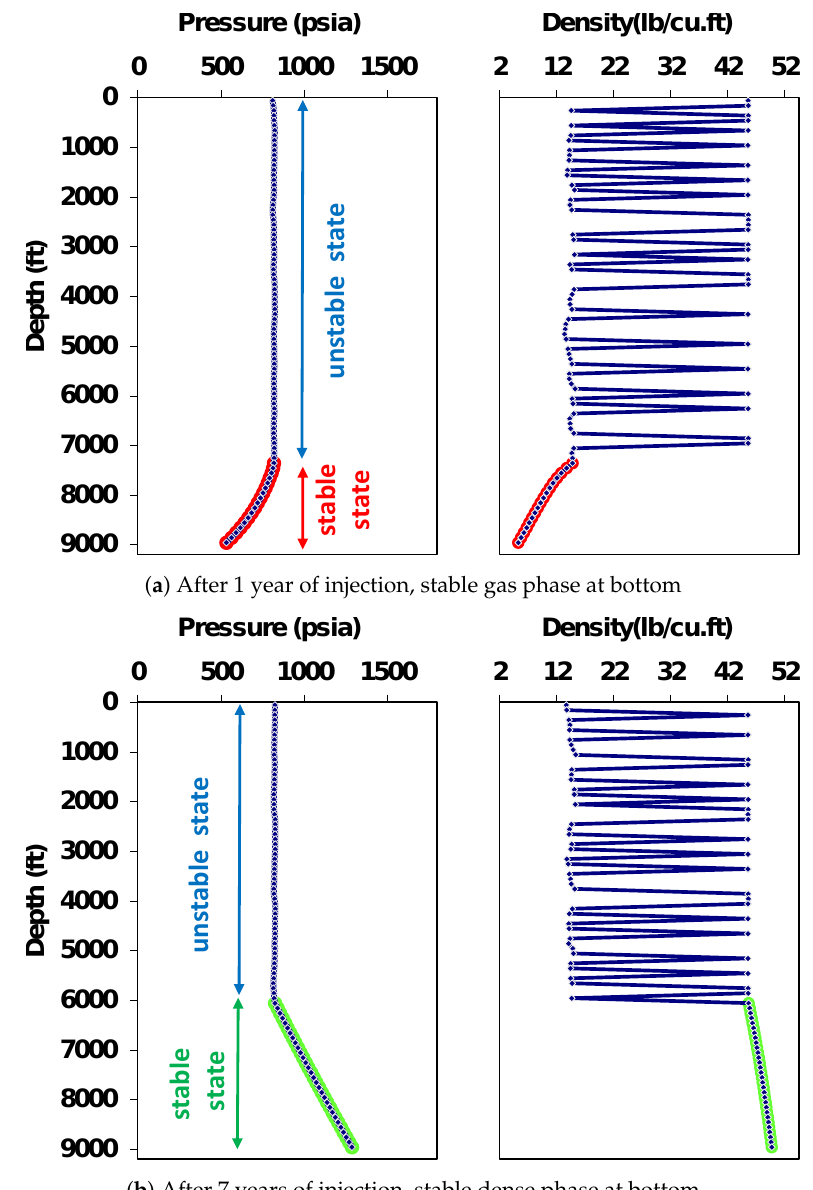
( b ) After 7 years of injection, stable dense phase at bottom Figure 12. Pressure and CO 2 density versus depth in the wellbore after 1 year ( a ) and 7 years ( b ) of injection. One unstable two-phase region in the upper section and one stable single phase region in the lower section of the